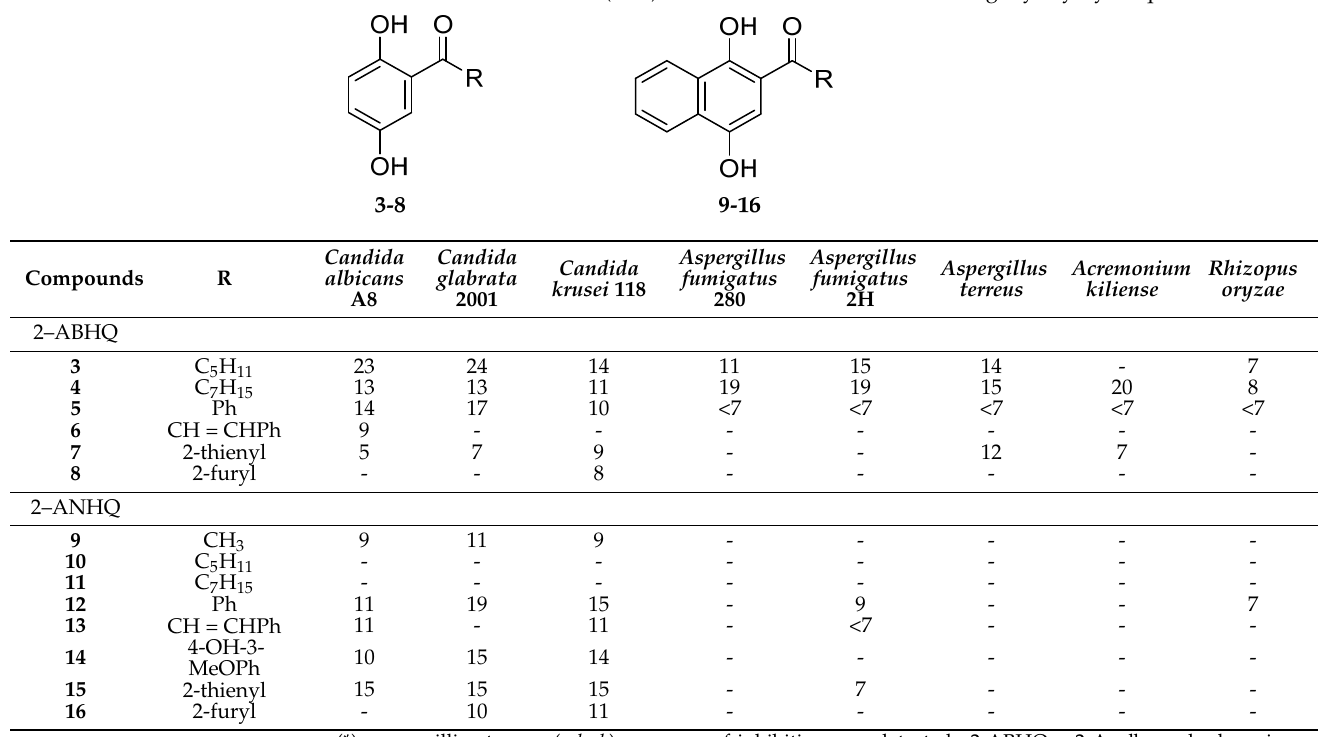
Table 1. Halo of inhibition (mm) * of Candida and filamentous fungi by acylhydroquinones.